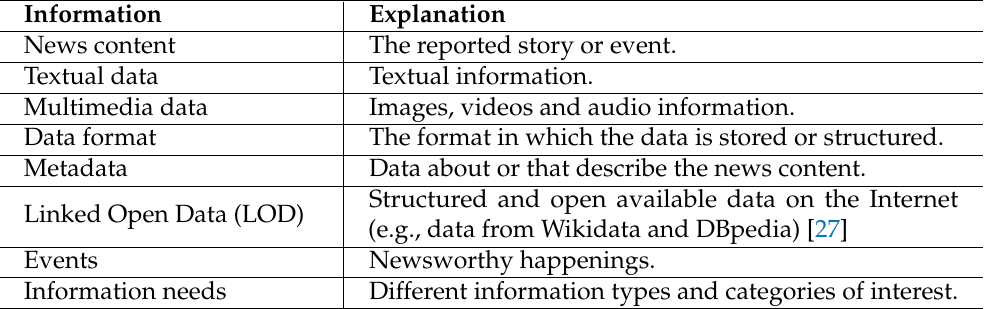
Table 2. The most common types of information managed by